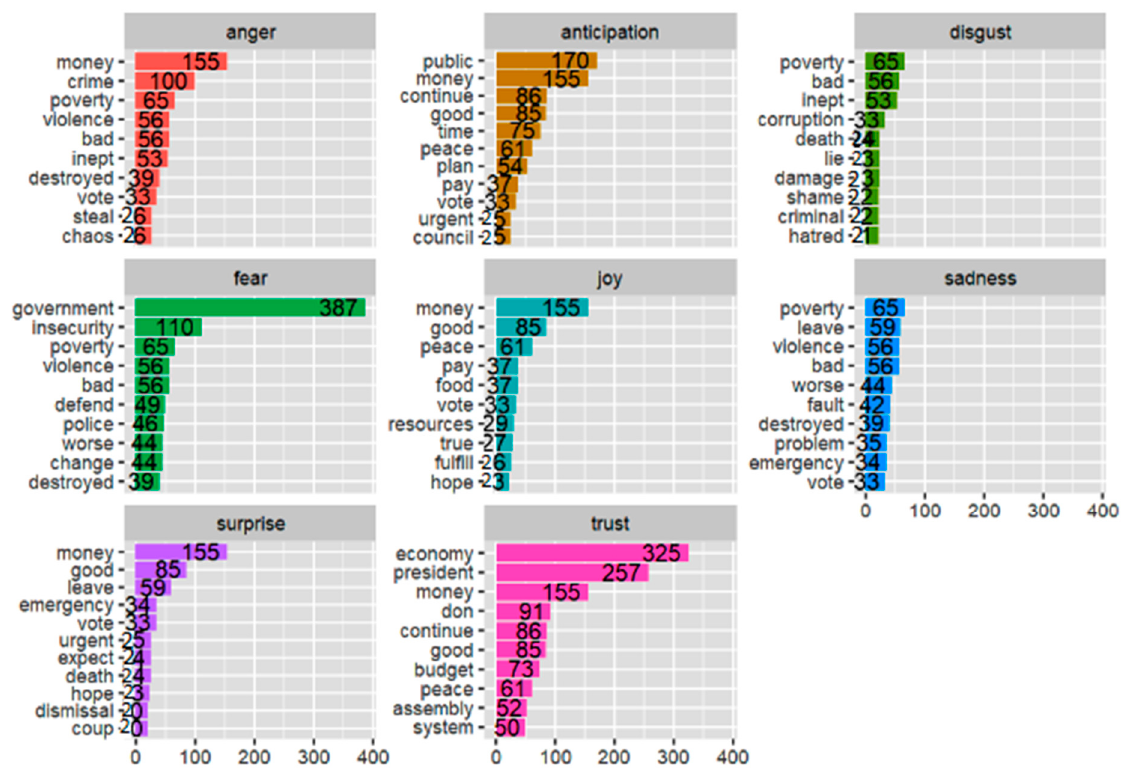
Figure 6. Identification of feelings with the TOP words with the highest repetition on Twitter.